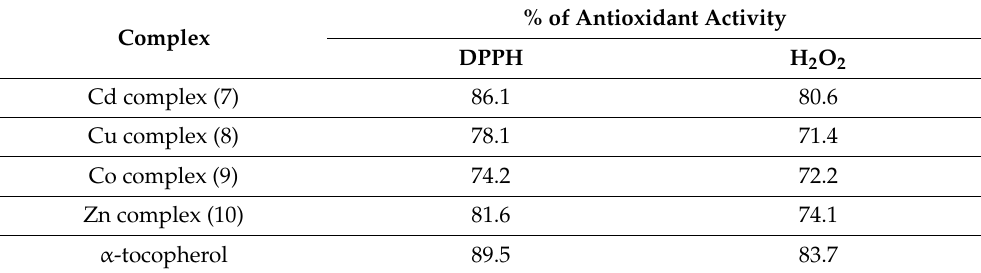
Table 1. Antioxidant performance of (7–10) metal chelates [137].